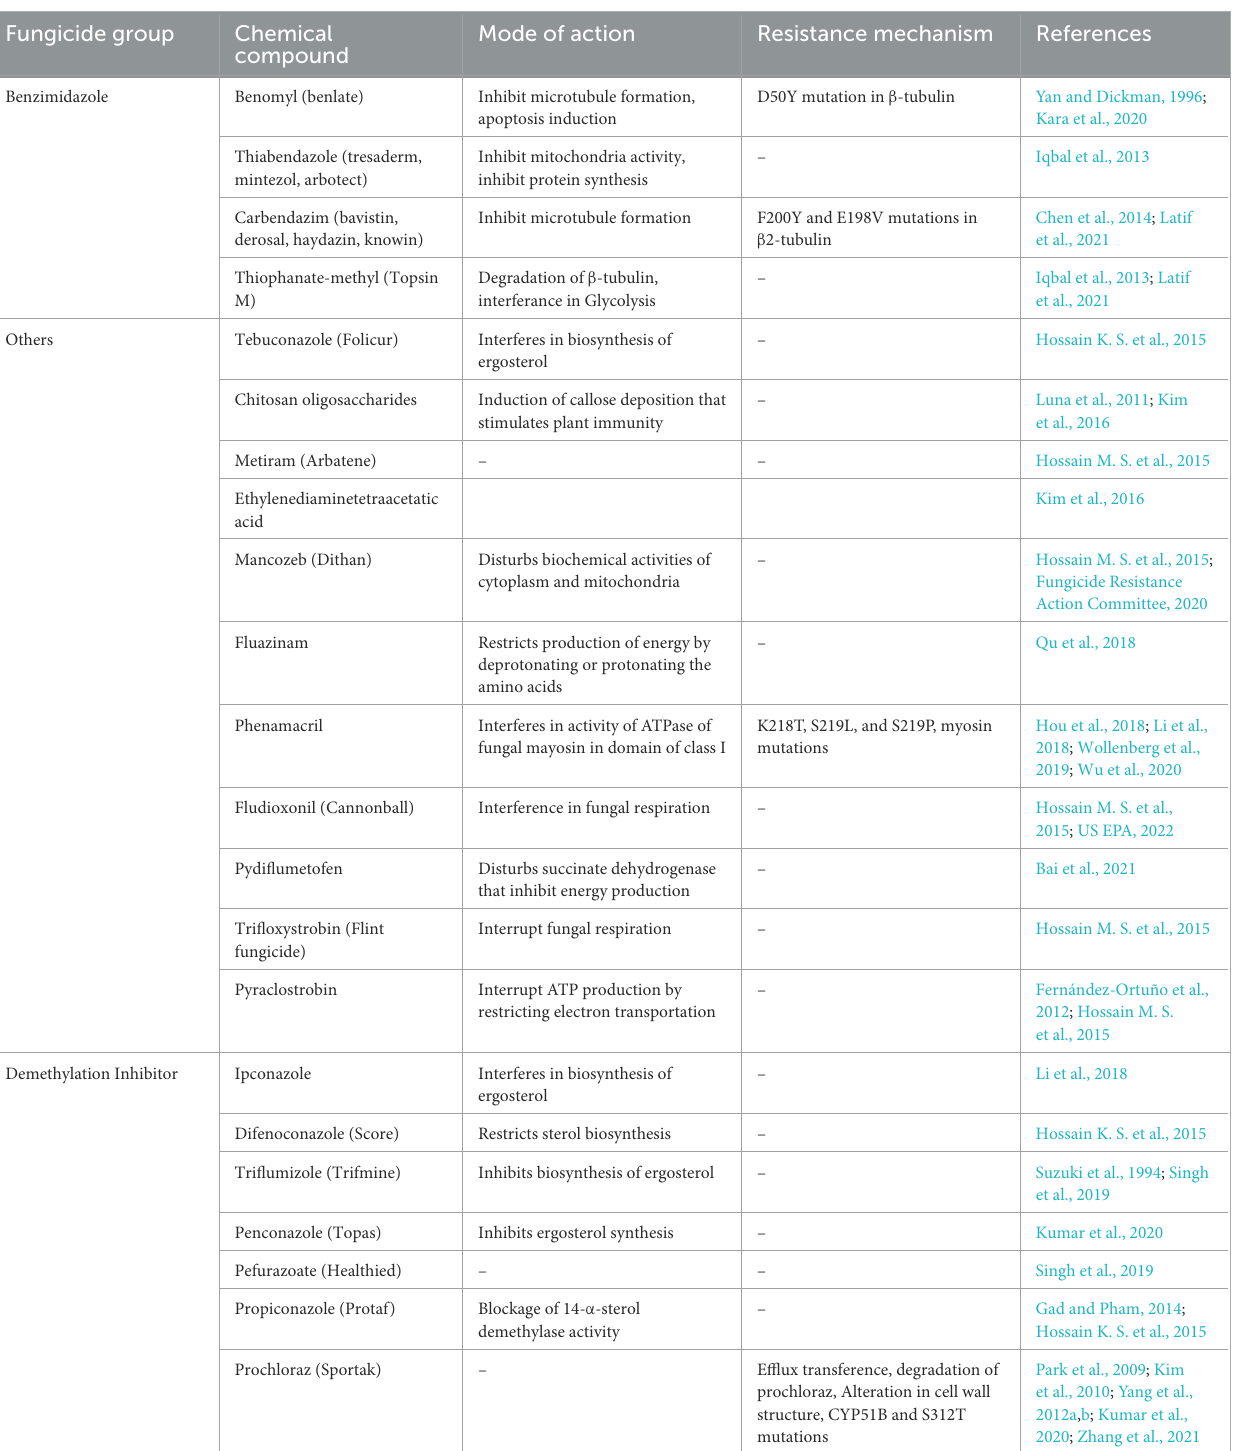
TABLE 3 Fungicides used against the bakanae disease of